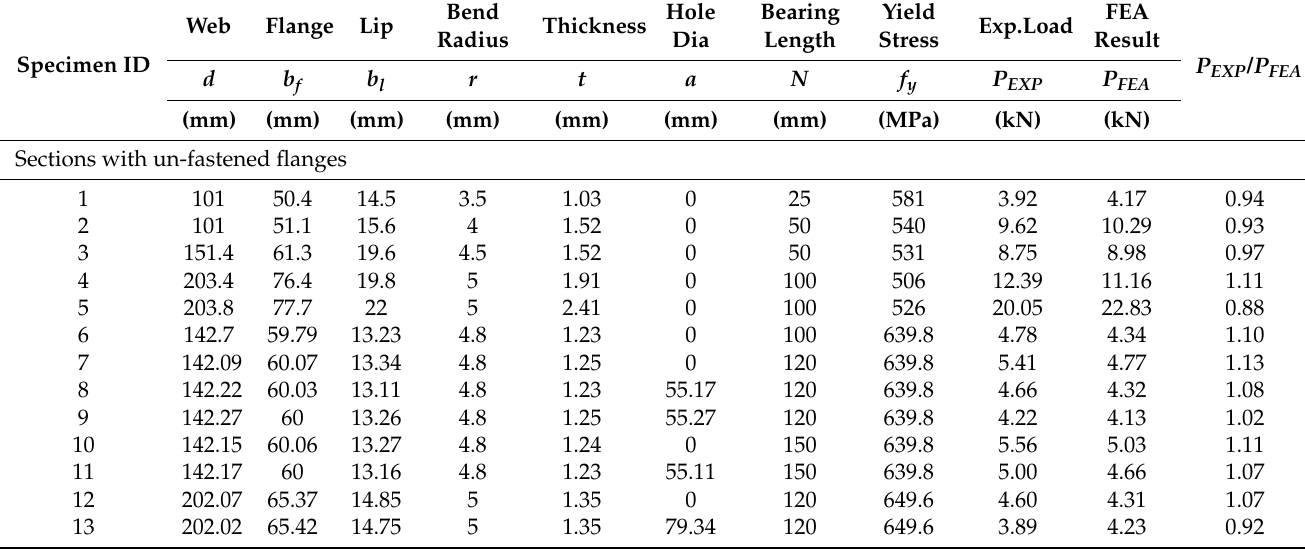
Table 3. Comparison of FEA results with the experimental investigations from Lian et al. [15] and Sundararajah et al.